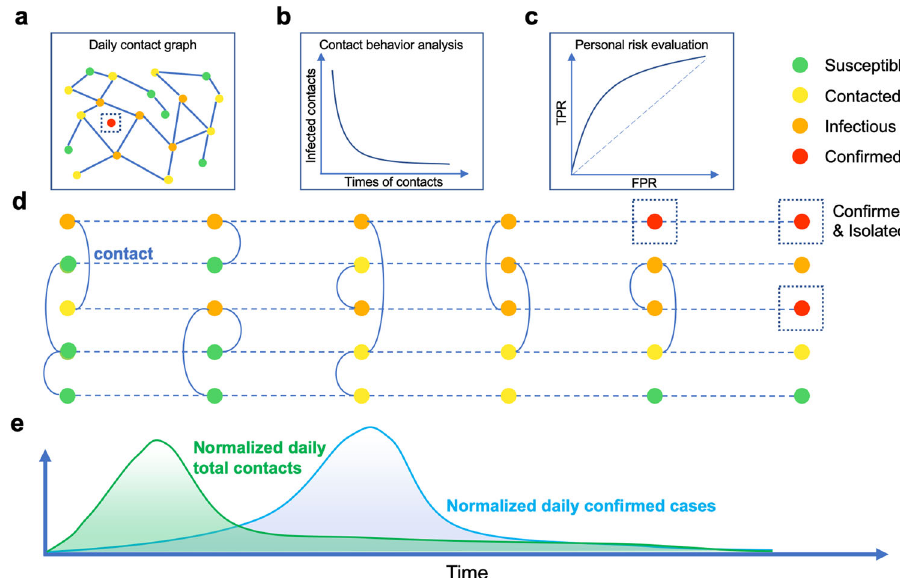
Fig. 1 Temporal contact graph and schematics for its potential applications. An individual has four status: susceptible, contacted, infectious and con fi rmed. The status `susceptible' turns to `contacted' when an individual had at least one contact with infectious individuals. A contacted individual may be infected or stay healthy. The status `infectious' changes to `con fi rmed' when con fi rmation is made. In China, con fi rmed cases will be quarantined for treatment and no longer infectious to others. a Daily contact graph. b The analysis for contact behaviors shows the distributions of contact counts between infected and uninfected contacted individuals. c The personal risk evaluation based on contact behaviors. d Contact history and status of individuals. A node denotes an individual and different colors indicate different status. A dashed line means the status evolution of a single individual in timeline, and a solid curve between two individuals means a contact. e The correlation between normalized daily total contacts and daily con fi rmed cases. The panels here are illustrative